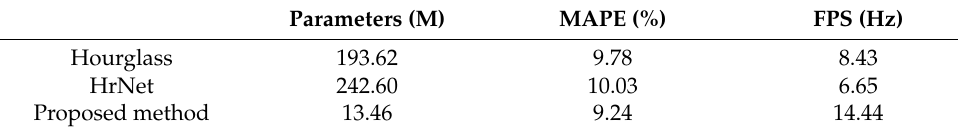
Table 1. Comparison of detection results of spinal key